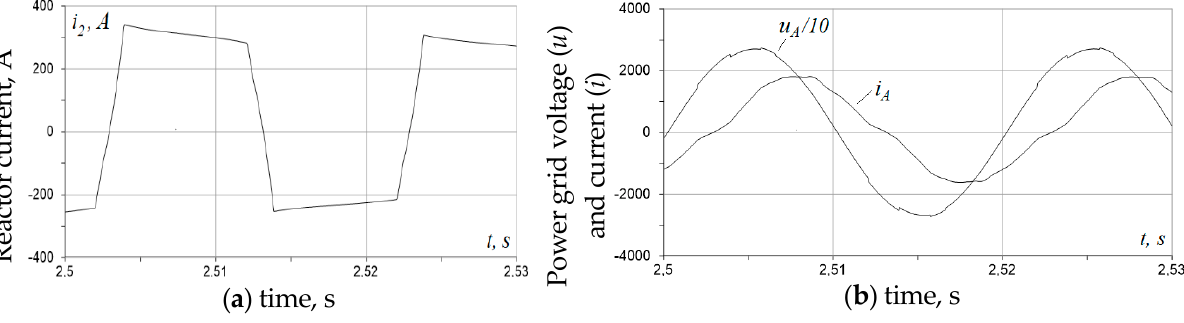
Figure 8. Choke current ( a ), mains voltage and current ( b ) based on the results of computer simulation. A functional diagram of the electrode movement system is shown in Figure